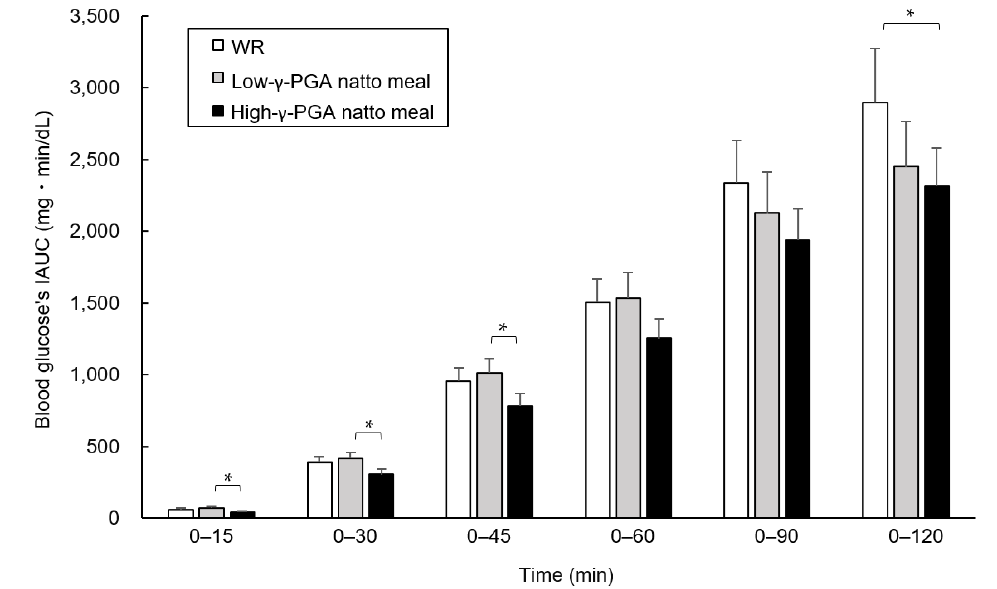
Figure 3. Comparison of the blood glucose’s incremental area under the curve (IAUC) between the test meals at each time point. The blood glucose’s IAUCs at 0–15, 0–30, 0–45, 0–60, 0–90, and 0–120 min were compared using a linear mixed model regression analysis with the test meals and groups as fixed effects, and the data are shown as the estimated mean ± the standard error (est. mean ± SE). * p < 0.05. WR: white rice; γ-PGA: gamma-polyglutamic acid.